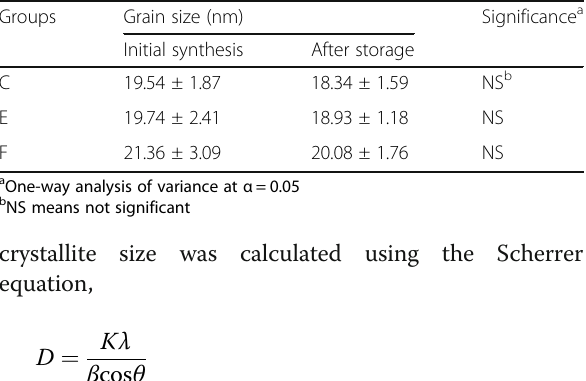
Table 2 The grain size of Cu NPs in group C, E, and F